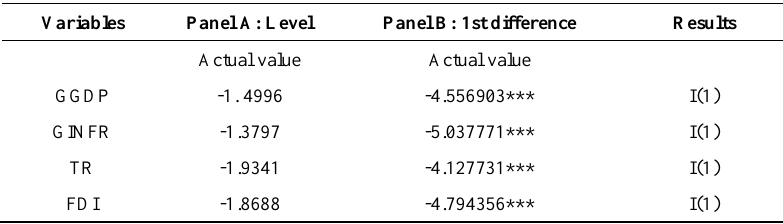
Table 2. Results of ADF unit root test.